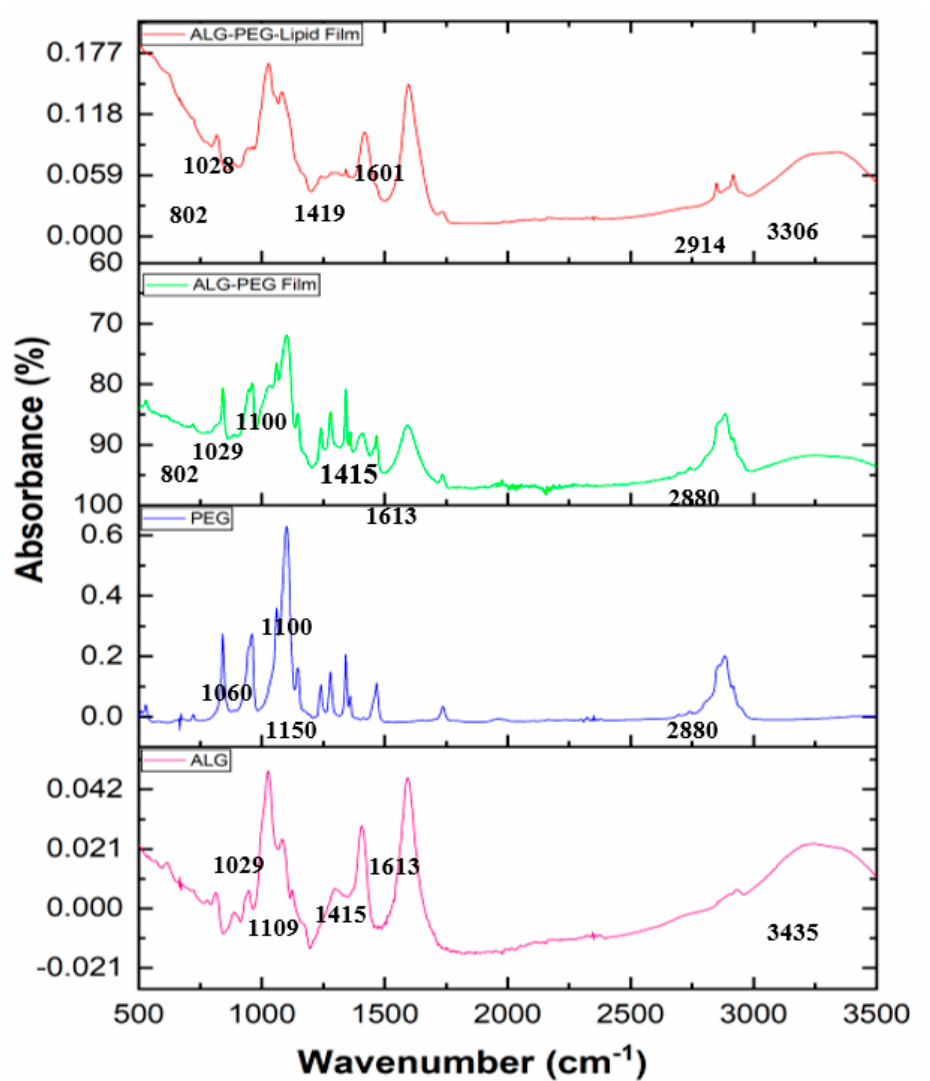
Figure 6. FTIR spectra of the pristine sodium alginate and PEG-40S used, and the resultant alginate–PEG and alginate–PEG–phospholipid porous films obtained (alginate, PEG-40S, alginate–PEG-40S, and alginate–PEG-40S and phospholipid are denoted by ALG, PEG, ALG–PEG, and ALG–PEG–Lipid, respectively).